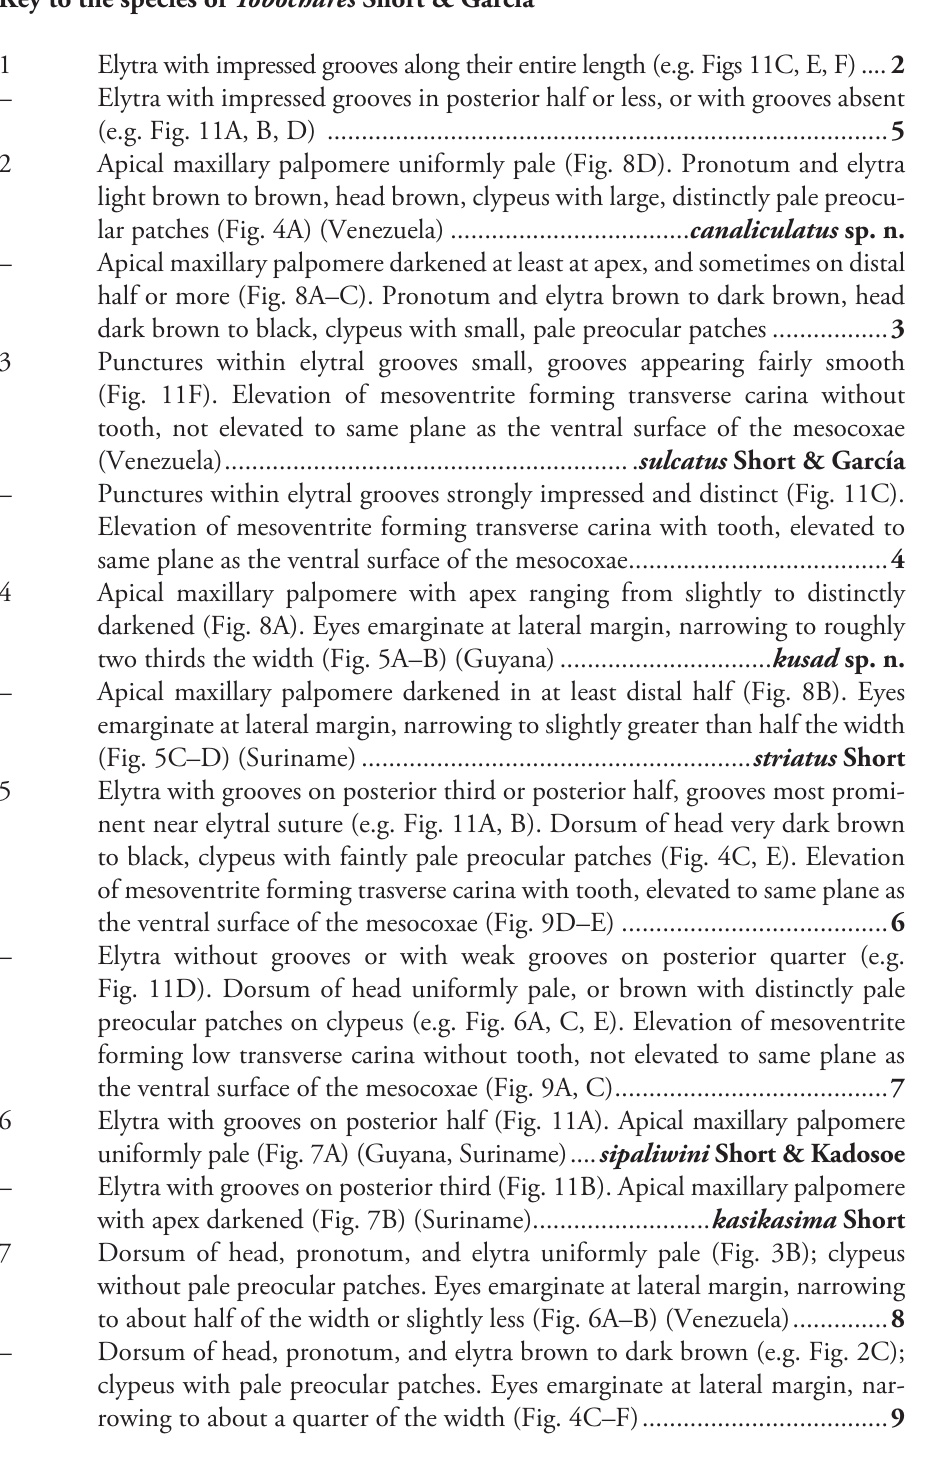
1 Elytra with impressed grooves along their entire length (e.g. Figs 11C, E, F) .... 2 – Elytra with impressed grooves in posterior half or less, or with grooves absent (e.g. Fig. 11A, B, D) .................................................................................. 5 2 Apical maxillary palpomere uniformly pale (Fig. 8D). Pronotum and elytra light brown to brown, head brown, clypeus with large, distinctly pale preocu- lar patches (Fig. 4A) (Venezuela) ................................... canaliculatus sp. n. – Apical maxillary palpomere darkened at least at apex, and sometimes on distal half or more (Fig. 8A–C). Pronotum and elytra brown to dark brown, head dark brown to black, clypeus with small, pale preocular patches ................. 3 3 Punctures within elytral grooves small, grooves appearing fairly smooth (Fig. 11F). Elevation of mesoventrite forming transverse carina without tooth, not elevated to same plane as the ventral surface of the mesocoxae (Venezuela) ............................................................ sulcatus Short & García – Punctures within elytral grooves strongly impressed and distinct (Fig. 11C). Elevation of mesoventrite forming transverse carina with tooth, elevated to same plane as the ventral surface of the mesocoxae ...................................... 4 4 Apical maxillary palpomere with apex ranging from slightly to distinctly darkened (Fig. 8A). Eyes emarginate at lateral margin, narrowing to roughly two thirds the width (Fig. 5A–B) (Guyana) ............................... kusad sp. n. – Apical maxillary palpomere darkened in at least distal half (Fig. 8B). Eyes emarginate at lateral margin, narrowing to slightly greater than half the width (Fig. 5C–D) (Suriname) ......................................................... striatus Short 5 Elytra with grooves on posterior third or posterior half, grooves most promi- nent near elytral suture (e.g. Fig. 11A, B). Dorsum of head very dark brown to black, clypeus with faintly pale preocular patches (Fig. 4C, E). Elevation of mesoventrite forming trasverse carina with tooth, elevated to same plane as the ventral surface of the mesocoxae (Fig. 9D–E) ....................................... 6 – Elytra without grooves or with weak grooves on posterior quarter (e.g. Fig. 11D). Dorsum of head uniformly pale, or brown with distinctly pale preocular patches on clypeus (e.g. Fig. 6A, C, E). Elevation of mesoventrite forming low transverse carina without tooth, not elevated to same plane as the ventral surface of the mesocoxae (Fig. 9A, C) ........................................ 7 6 Elytra with grooves on posterior half (Fig. 11A). Apical maxillary palpomere uniformly pale (Fig. 7A) (Guyana, Suriname) .... sipaliwini Short & Kadosoe – Elytra with grooves on posterior third (Fig. 11B). Apical maxillary palpomere with apex darkened (Fig. 7B) (Suriname).......................... kasikasima Short 7 Dorsum of head, pronotum, and elytra uniformly pale (Fig. 3B); clypeus without pale preocular patches. Eyes emarginate at lateral margin, narrowing to about half of the width or slightly less (Fig. 6A–B) (Venezuela) .............. 8 – Dorsum of head, pronotum, and elytra brown to dark brown (e.g. Fig. 2C); clypeus with pale preocular patches. Eyes emarginate at lateral margin, nar- rowing to about a quarter of the width (Fig. 4C–F) ....................................